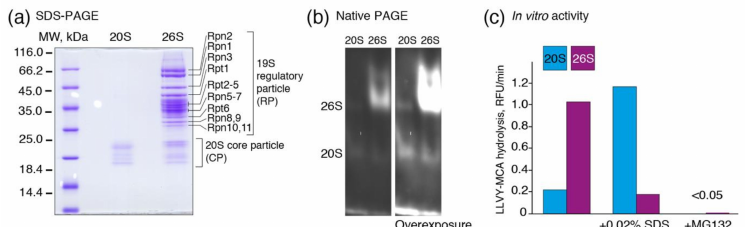
Figure 1. ( a ) The purified 20S (1.5 µ g) and 26S (5.0 µ g) proteasomes were subjected to polyacrylamide gel electrophoresis and further stained with Coomassie blue R250. Subunits of the 19S regulatory particle and the molecular weight marker are indicated. ( b , c ) The activity of 20S and 26S proteasomes was analyzed by native PAGE further saturated with Suc-LLVY-AMC ( b ) or measured in the presence or absence of 0.02% SDS and the proteasome inhibitor MG132 ( c